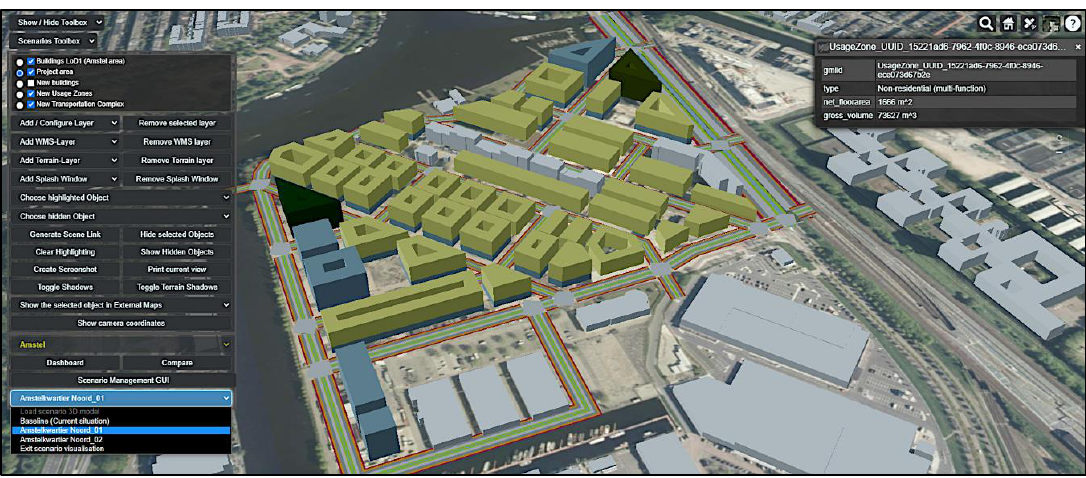
Figure 24. Visualization in CesiumJS of a scenario via the extended graphical user interface of the 3DCityDB web-map client.